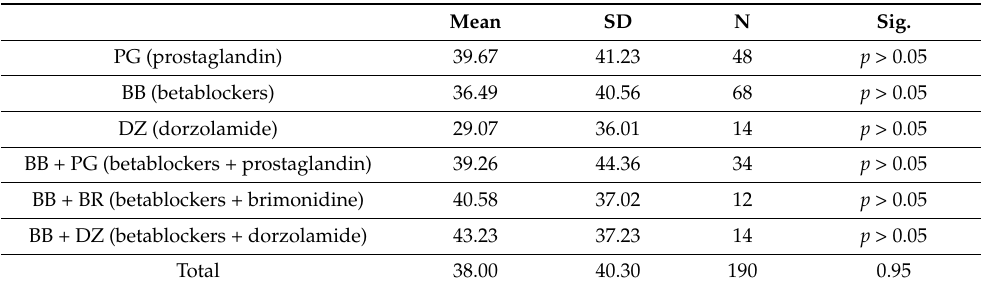
Table 3. Mean duration and standard deviation in months of the therapies included in the study with statistical testing of differences.